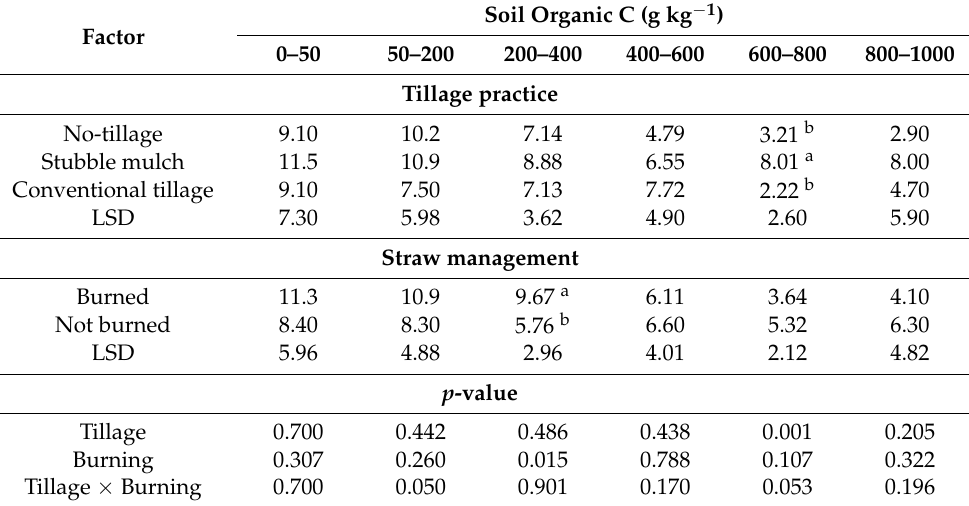
Table 1. The effect of tillage and straw management on the soil organic carbon in the 0–1000 mm layers. Factor